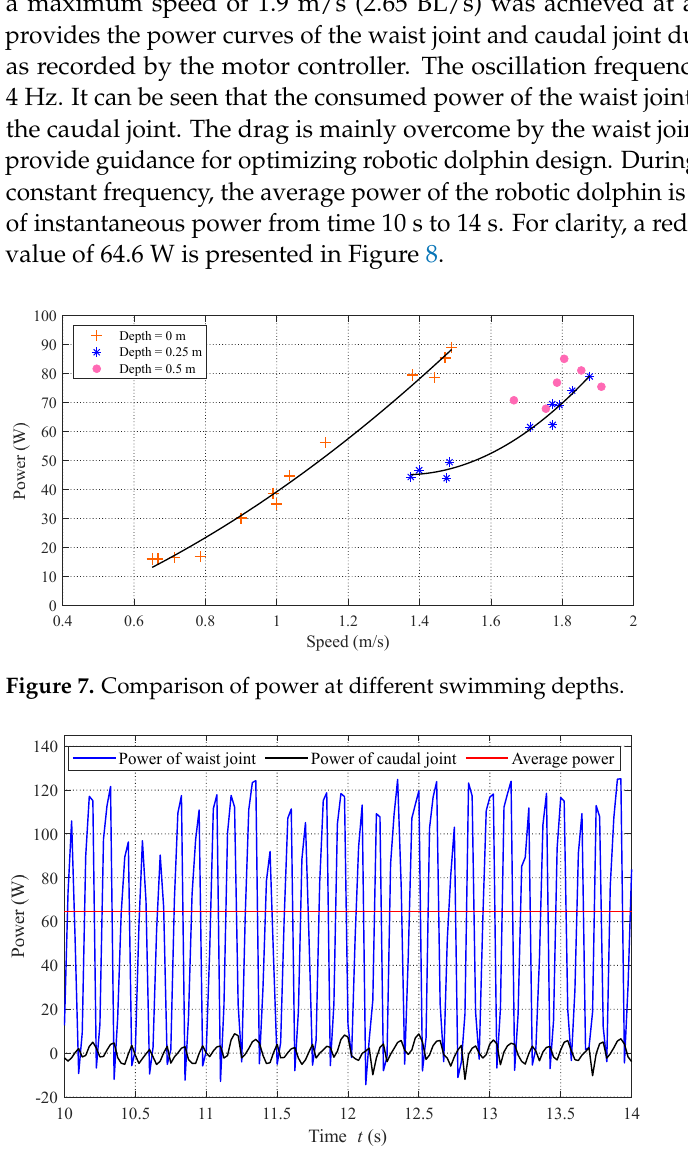
Figure 8. Measured power of the robotic dolphin during